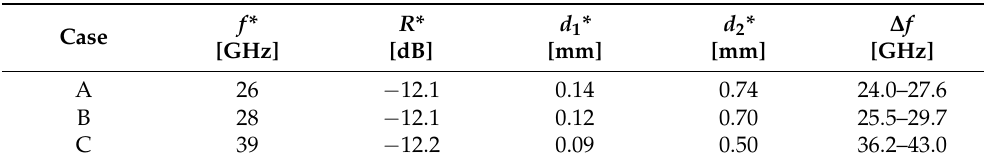
Table 2. Optimal thicknesses, lower minimum reflection coefficient and bandwidths at − 10 dB for composite filled with 2% of GNPs at target frequencies in case of normal incidence.